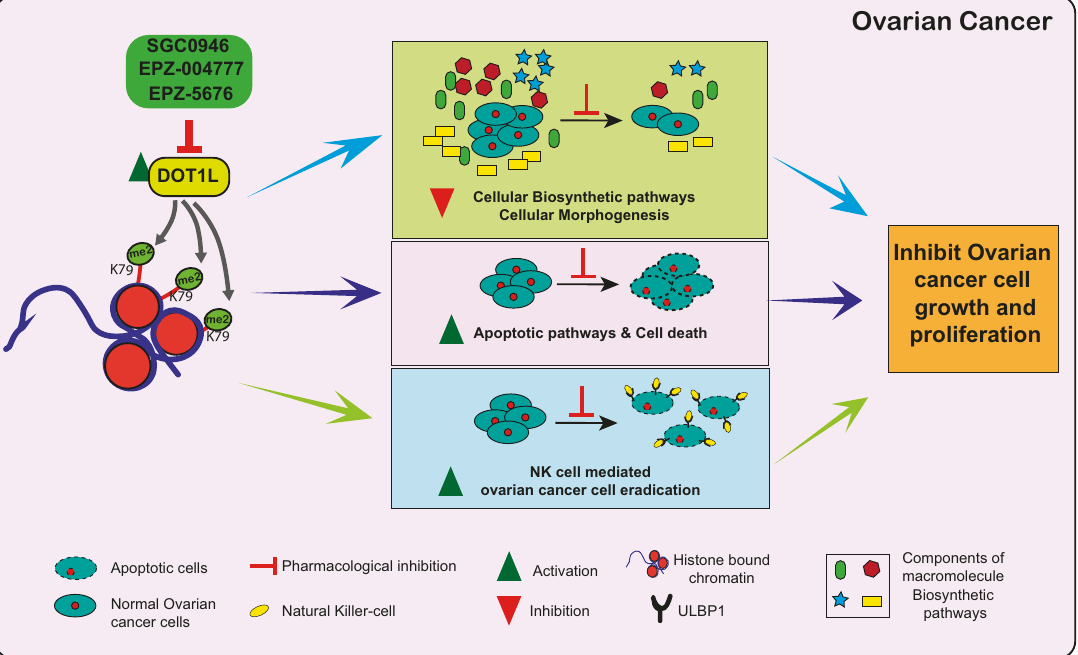
Fig. 7 A model of DOT1L function in ovarian cancer. DOT1L promotes ovarian cancer growth and metastasis by upregulating cellular biosynthesis and morphogenesis pathways, downregulating apoptotic and cell death signaling pathways, and inhibiting NK cell-mediated ovarian cancer cell